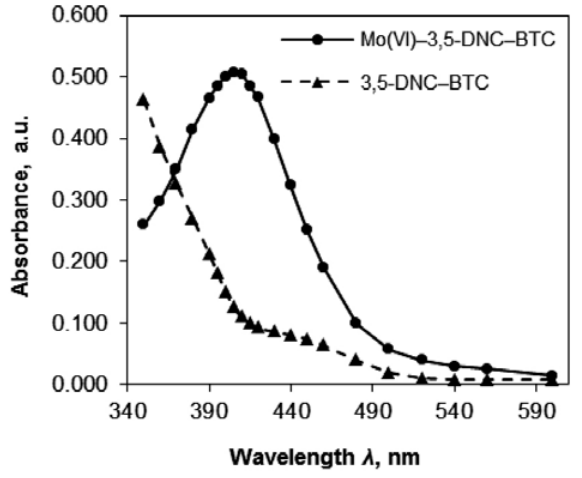
Figure 1. Absorption spectra of the complex Mo(VI)–3,5- DNC–BTC and of the blank sample 3,5-DNC–BTC in CHCl = 3.12 × 10 –5 mol L –1 ; C mol L –1 ; C